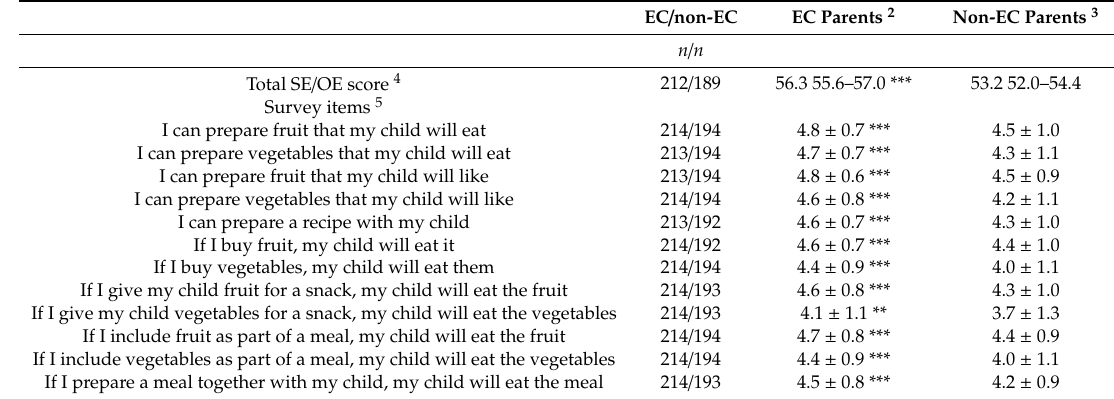
Figure 1. Parent eating competence (EC) proportion mapped to response options for selected modeling items. Response option of selected modeling survey item by EC and non-EC parents of 4th grade children. Figure 1 shows percent of total responses. Described below for each panel are the total number of parents that responded, the total number of parents for the response option, and the total number of EC parents for the response option. ( A ) Total responses, n = 408; 0–3 days / week (total n = 26, EC n = 8); 4–6 days / week (total n = 219, EC n = 104); every day (total n = 163, EC n = 102). ( B ) Total responses, n = 408; never (total n = 103, EC n = 46); sometimes (total n = 223, EC n = 111); often (total n = 56, EC n = 40); always (total n = 26, EC n = 17). ( C ) Total responses, n = 407; never (total n = 56, EC n = 22); sometimes (total n = 308, EC n = 165); often (total n = 28, EC n = 14); always (total n = 15, EC n = 13). ( D ) Total responses, n = 407; never (total n = 44, EC n = 17); sometimes (total n = 244, EC n = 122); often (total n = 104, EC n = 66); always (total n = 15, EC n = 9). ( E ) Total responses, n = 407; sometimes (total n = 20, EC n = 6); often (total n = 132, EC n = 55), always (total n = 255, EC n = 153). ( F ) Total responses, n = 407; never / sometimes (total n = 67, EC n = 23); often (total n = 172, EC n = 79); always (total n = 168, EC n = 112). EC, eating competence. P values denote a test of whether or not response options for each question are independent of eating competence status as measured by Chi-square. Table 2. Self-e ffi cacy / outcome expectancies (SE / OE) score and item responses compared between EC and non-EC parents 1